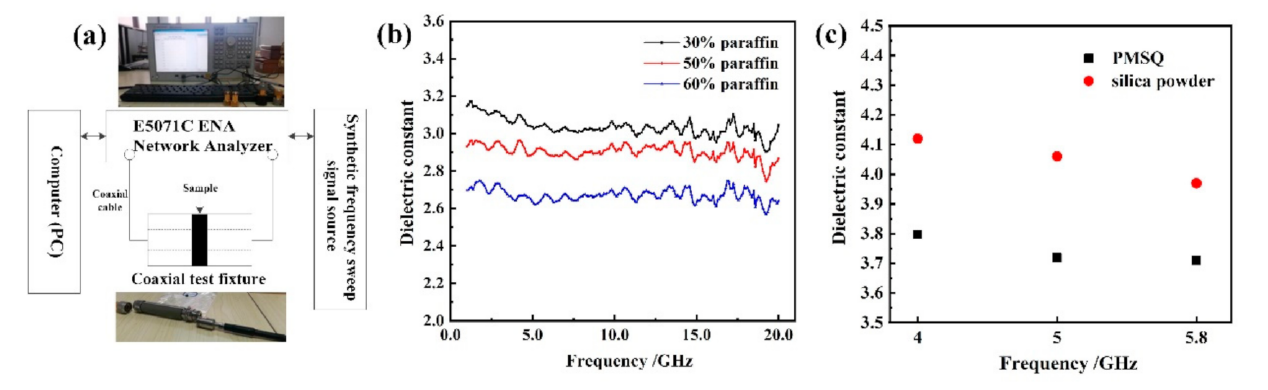
Figure 9. ( a ) Schematic diagram of coaxial transmission line test, ( b ) dielectric constant of PMSQ/paraffin composites with different mass fraction of paraffin, and ( c ) comparison of dielectric constant between PMSQ and silica